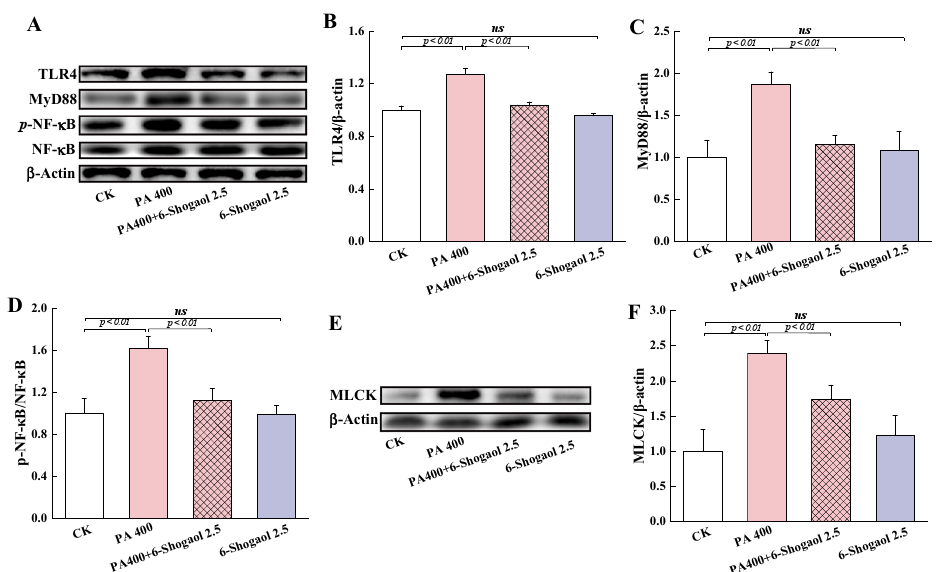
Figure 5. Effects of 6-shogaol on the TLR4/NF- κ B signaling pathway and the expression of MLCK protein in Caco-2 cells treated with PA: ( A ) Representative immunoblotting of TLR4, MyD88, p-NF- κ B, and NF- κ B; ( B ) Relative expression of TLR4; ( C ) Relative expression of MyD88; ( D ) The p -NF- κ B/NF- κ B ratio; € Representative immunoblotting of MLCK; ( F ) Relative expression of MLCk. β -Actin was used as the loading control for the quantification of TLR4, MyD88, and MLCK. Data are given as means ± standard deviations (n = 3). ns indicates no significant difference between the 6-shogaol-treated group and the control at p < 0.05.